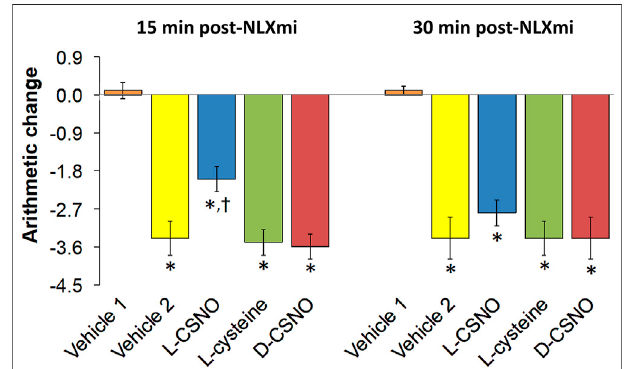
FIGURE 12 | Changes in tail- fl ick latencies 15 min (A) and 30 min (B) following injection of naloxone methiodide (NLXmi, 2.5 mg/kg, IV) given 30 min after the injection of vehicle (Vehicle 1) or fentanyl (50 μ g/kg, IV). The group denoted Vehicle 1 received an infusion of vehicle, three injections of vehicle and then NLXmi (2.5 mg/kg, IV) 30 min after the third injection of vehicle.ThegroupdenotedVehicle2receivedaninfusionofvehiclefor60 min before injection with 10, 25, or 50 μ g/kg doses of fentanyl given 30 min apart and then an injection of vehicle 30 min after injection of 50 μ g/kg dose of fentanyl. Infusion groups denoted as L-CSNO (S-nitroso-L-cysteine, 200 nmol/kg/min), L-cysteine (200 nmol/kg/min) or D-CSNO (S-nitroso-D- cysteine,200 nmol/kg/min)wereinfusedfor60 minbeforereceivinginjections of 10, 25, or 50 μ g/kg doses of fentanyl given 30 min apart and then an injection of NLXmi (2.5 mg/kg, IV) given 30 min after the injection of 50 μ g/kg dose offentanyl. The dataarepresentedasmean ±SEM.There were6rats in each group. * p < 0.05, signi fi cantchangefrom Prevalues. † p < 0.05, L-CSNO versus Vehicle 2, L-cysteine and